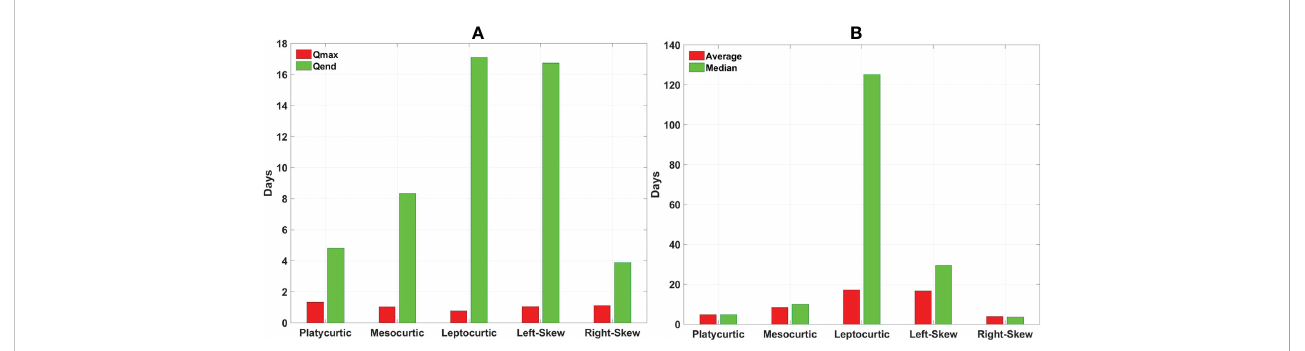
FIGURE 7 The fl ushing time for each simulation calculated using the Date Speci fi c Method (DSM) to determine the river discharge averaging period. (A) Comparison of the fl ushing time measured with the average river discharge over a period with the starting date at the day of the maximum fl ow (Qmax, red bars) and the last day of the simulation (Qend, green bars). (B) Comparison of the fl ushing time measured with the average (red bars) and the median (green bars) river discharge over a period with a starting date at the last day of the